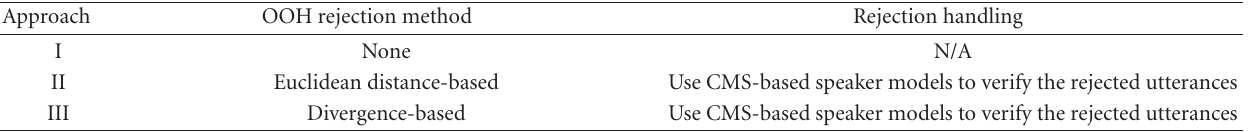
Table 3: Three di ff erent approaches to integrate OOH rejection into a speaker verification